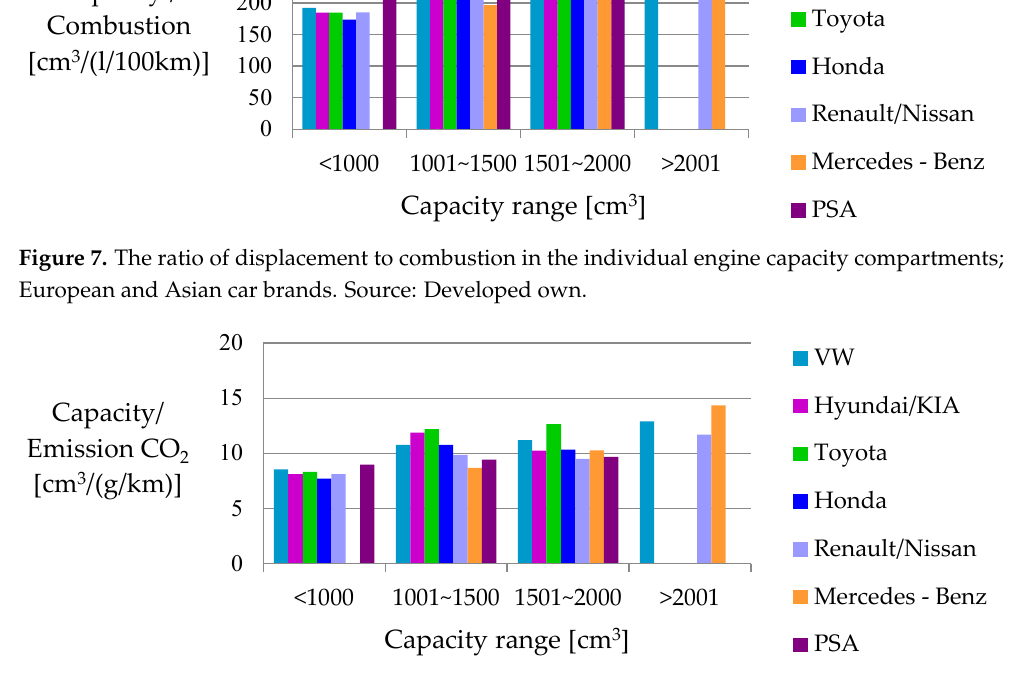
Figure 8. The ratio of engine capacity to emissions in each capacity compartment; European and